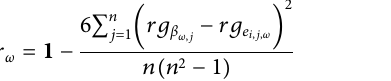
Frontiers in Cell and Developmental Biology |